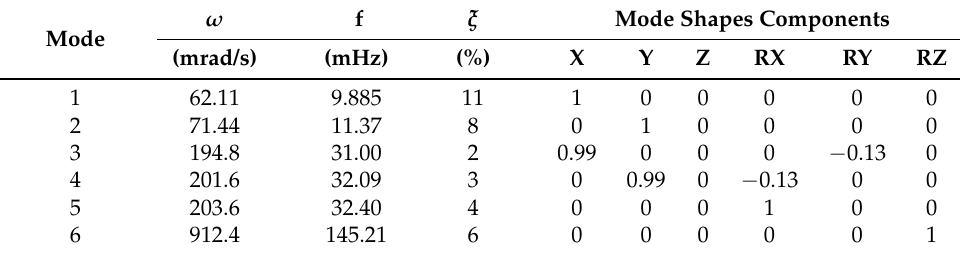
Table 4. Modal properties of the 6 rigid motion modes, including angular frequencies, natural frequencies, modal damping ratios, and 6 mode shape components of the spar numerical model implemented in ANSYS R (cid:13) AQWA (X-surge; Y-sway; Z-heave; RX-roll; RY-pitch; RZ-yaw). ω f ξ Mode Shapes Mode